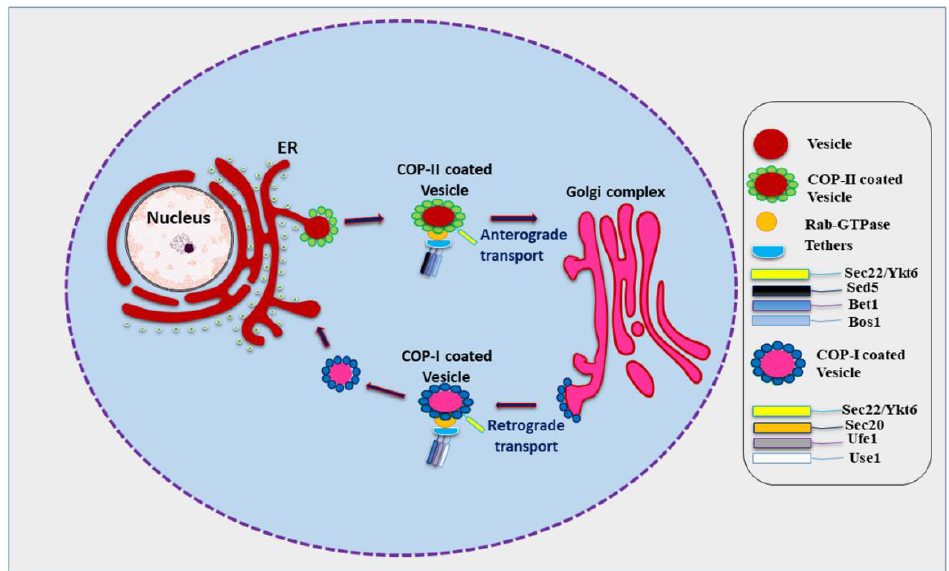
Figure 1. Role of SNARE proteins in anterograde and retrograde trafficking in yeast (Role of Sec22 during anterograde and retrograde trafficking along with compatible SNAREs and associated factors like COP-I (Coat Protein-I) and COP-II (Coat Protein-II), Rab-GTPase (Ras proteins related Guanosine Triphosphatase), and tethers. However, Ykt6 can replace Sec22 during retrograde trafficking from Golgi to endoplasmic reticulum (ER)).